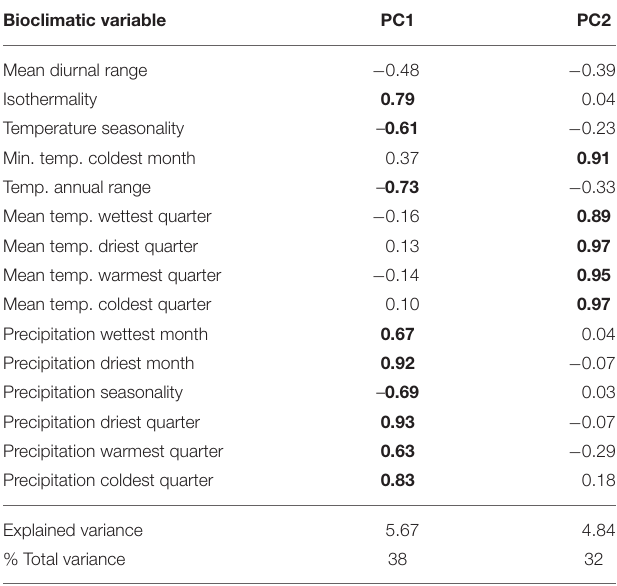
TABLE 1 | Principal component analysis of bioclimatic variables for Bactris gasipaes and contributions of the bioclimatic variables to the first two components.